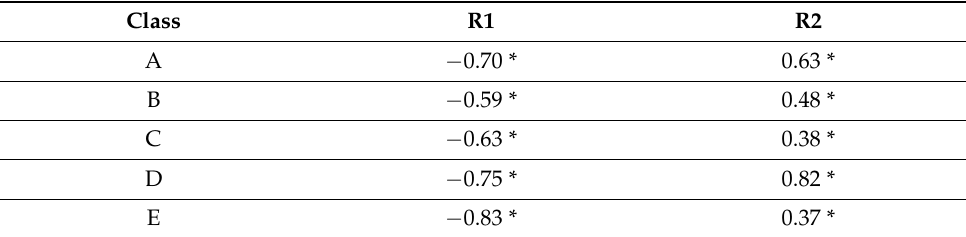
Table 2. Spearman coefficient of rank correlation between students’ performance and their results in the intelligence test and the performance and overall score achieved in